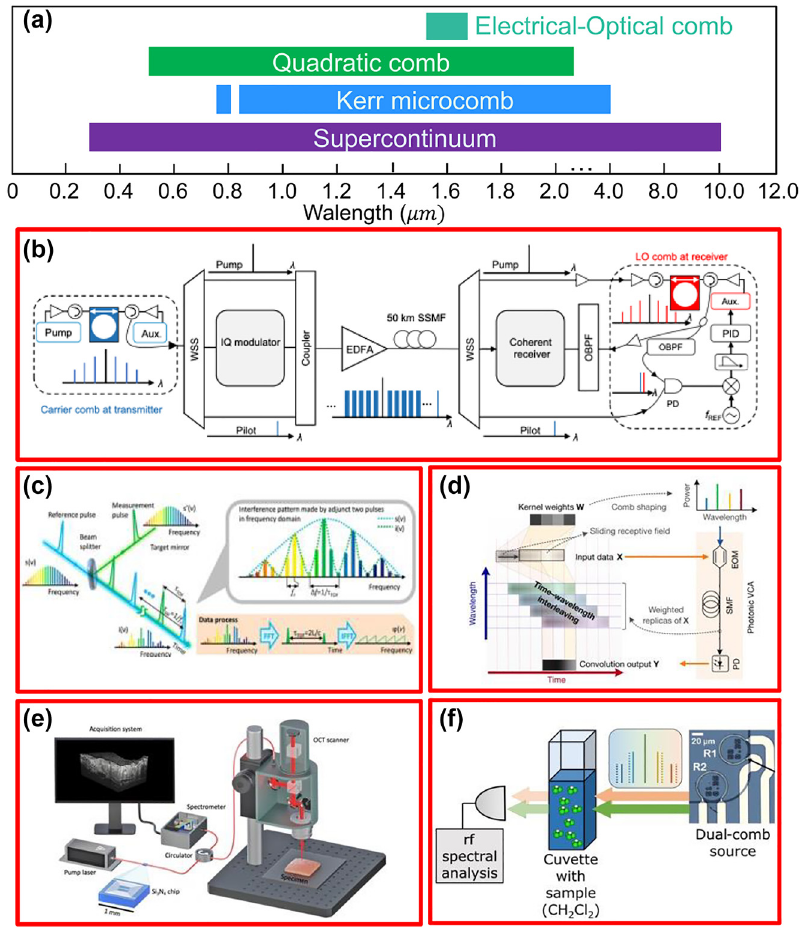
Figure 7: Typical OFC applications. (a) Map of the spectrum coverage for representative works using different comb-generation approaches (strips). (b) Optical interconnect using coherence-cloned DKS microcombs as carriers and Los [274]. (c) Architectural approach of the spectrally resolved ranging via soliton microcomb [247]. (d) Optical vector convolutional accelerator powered by a soliton crystal microcomb [7]. (e) Spectral domain